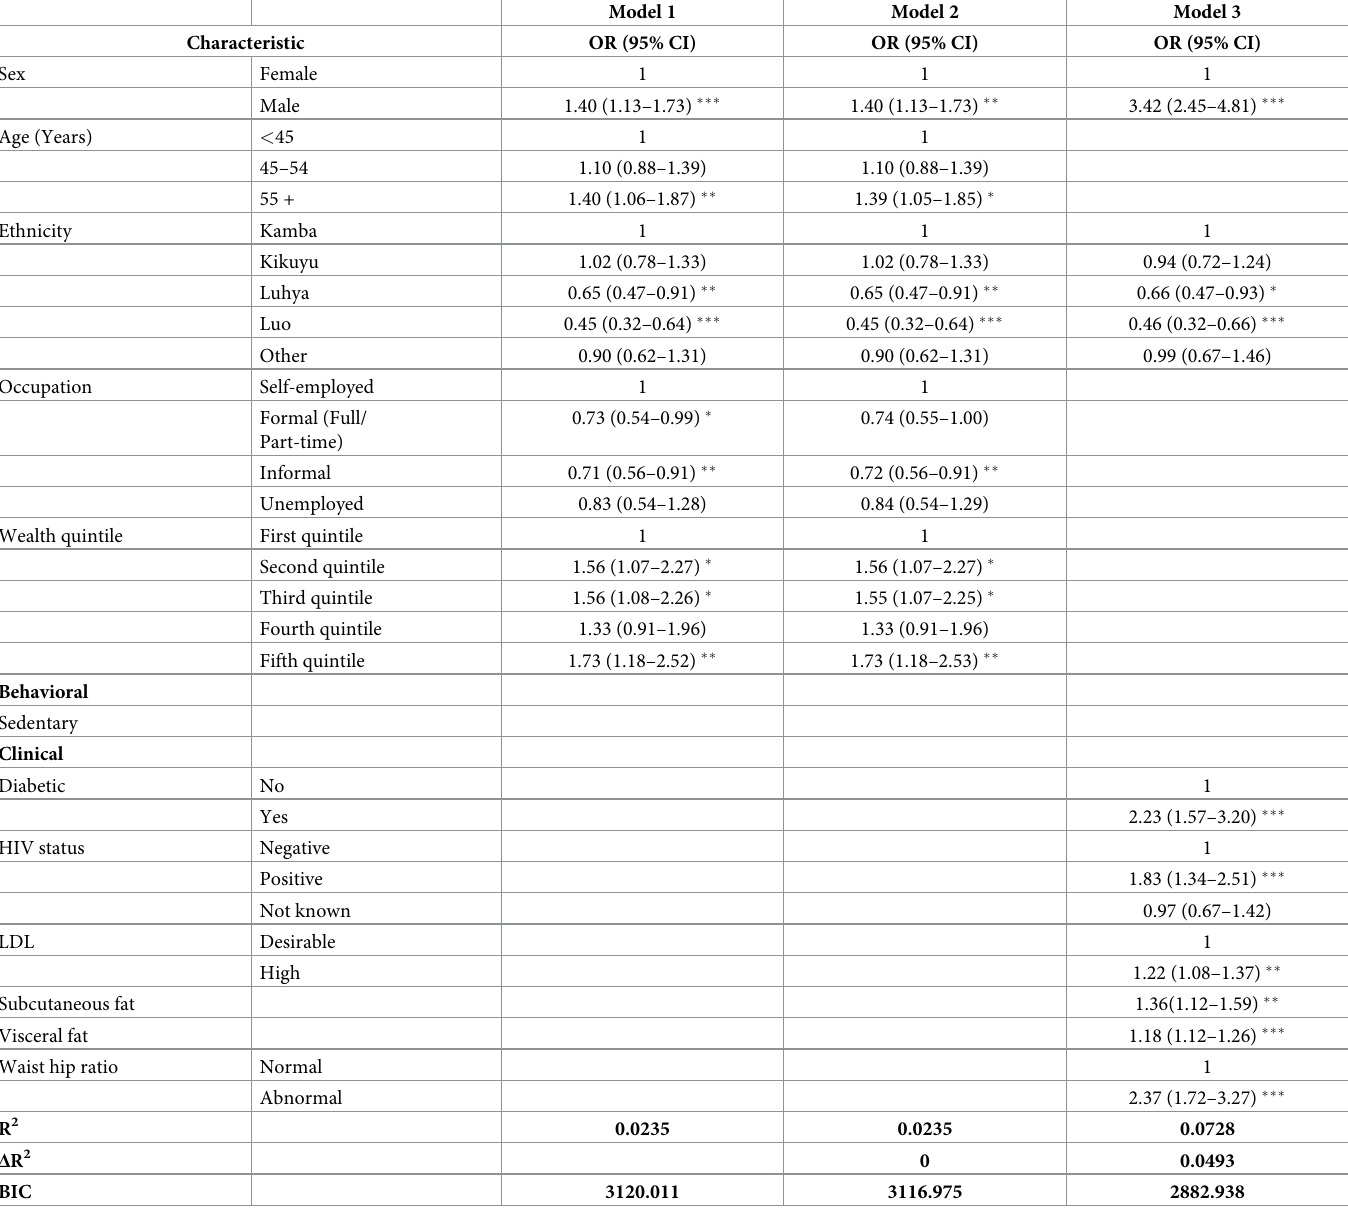
Table 4. Multivariate ordered regression models of factors associated with higher atherogenic